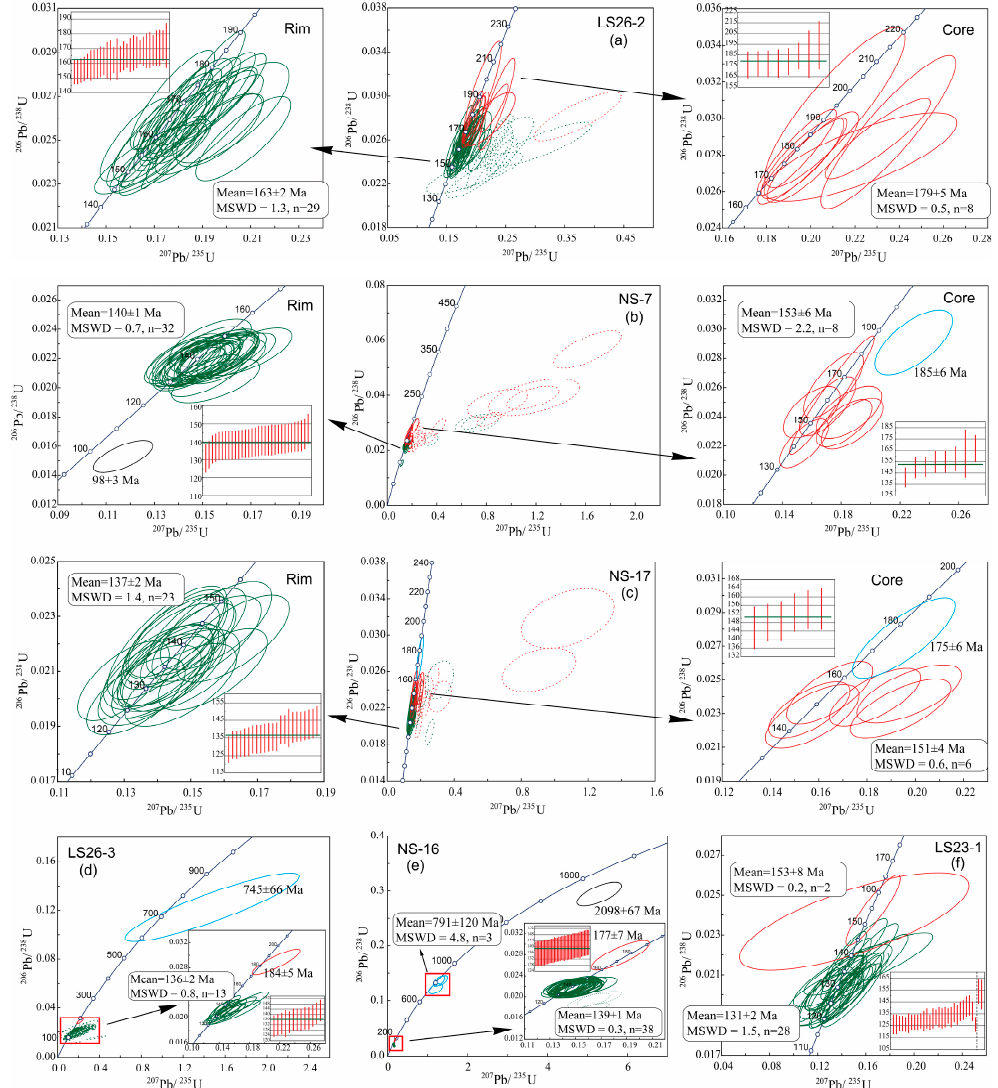
Figure 10. Zircon U-Pb concordia plots and recalculated weighted mean 206 Pb/ 238 U ages for sample LS26-2 ( a ; newly crystallized rims to the left and inherited cores to the right), sample NS-7 ( b ; newly crystallized rims to the left and inherited cores to the right), sample NS-17 ( c ; newly crystallized rims to the left and inherited cores to the right), sample LS26-3 ( d ), sample NS-16 ( e ) and sample LS23-1 ( f ).